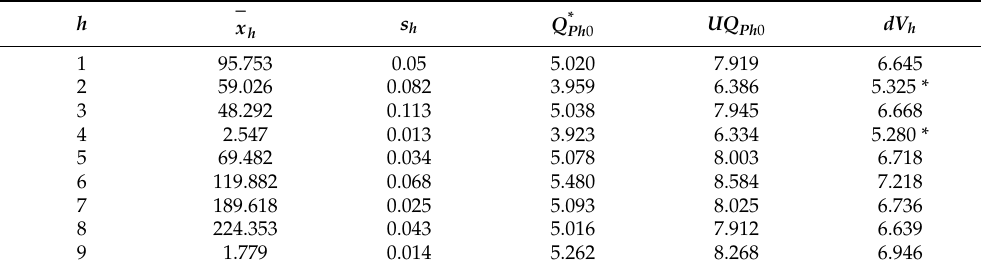
Table 2. Process evaluation results of 95 unleaded